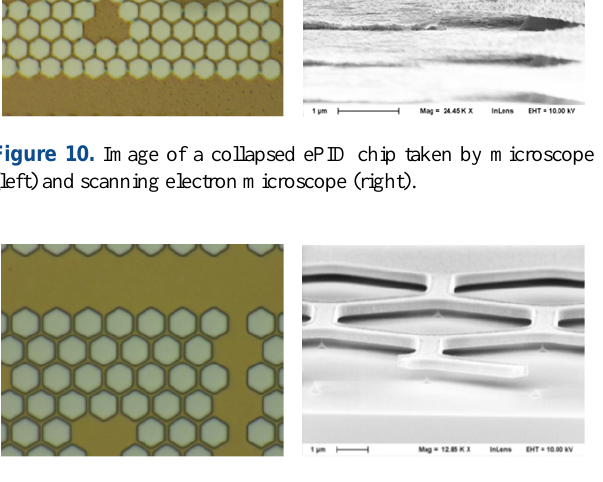
Figure 11. Image of an optimized ePID chip taken by microscope (left) and scanning electron microscope (right, Kallis et al., 2014).